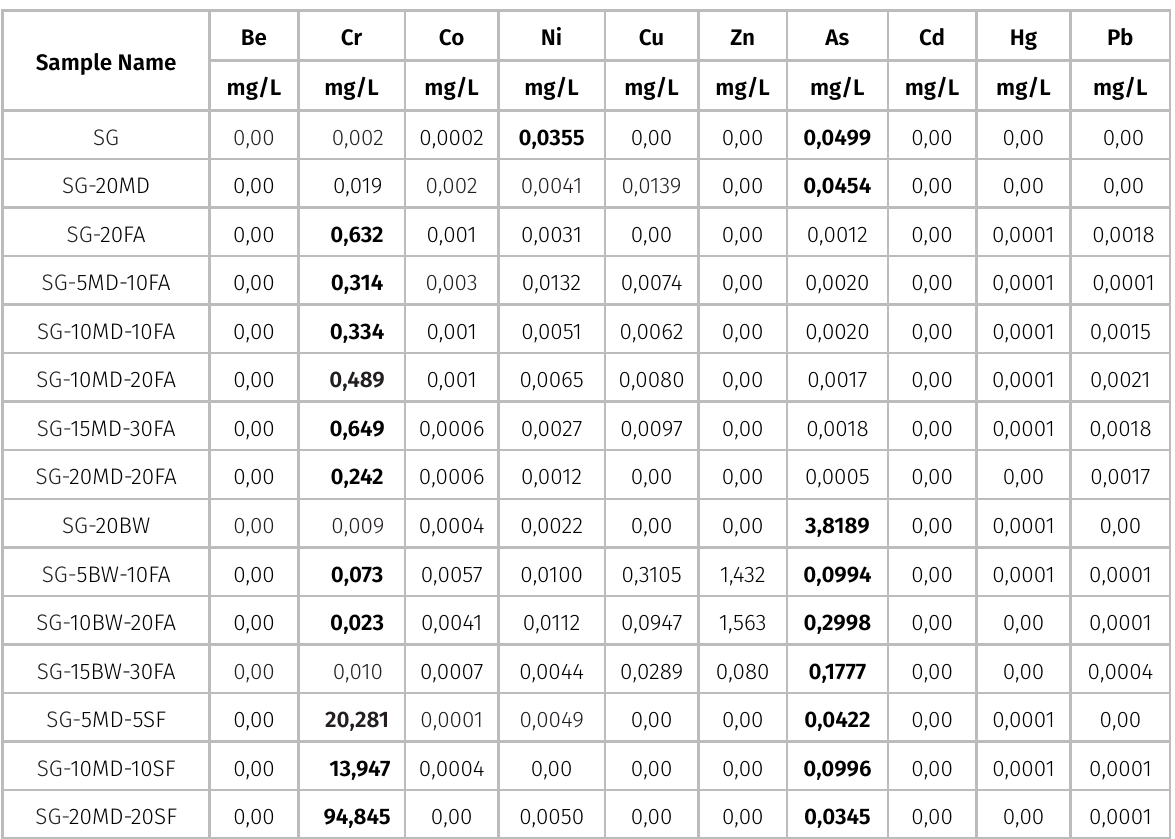
Table IV. The measured trace elements from leachates by